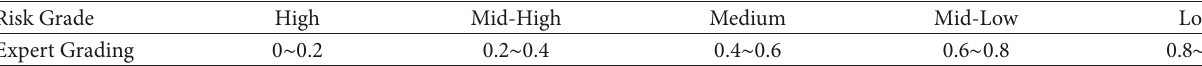
Table 1: Experts’ criteria for